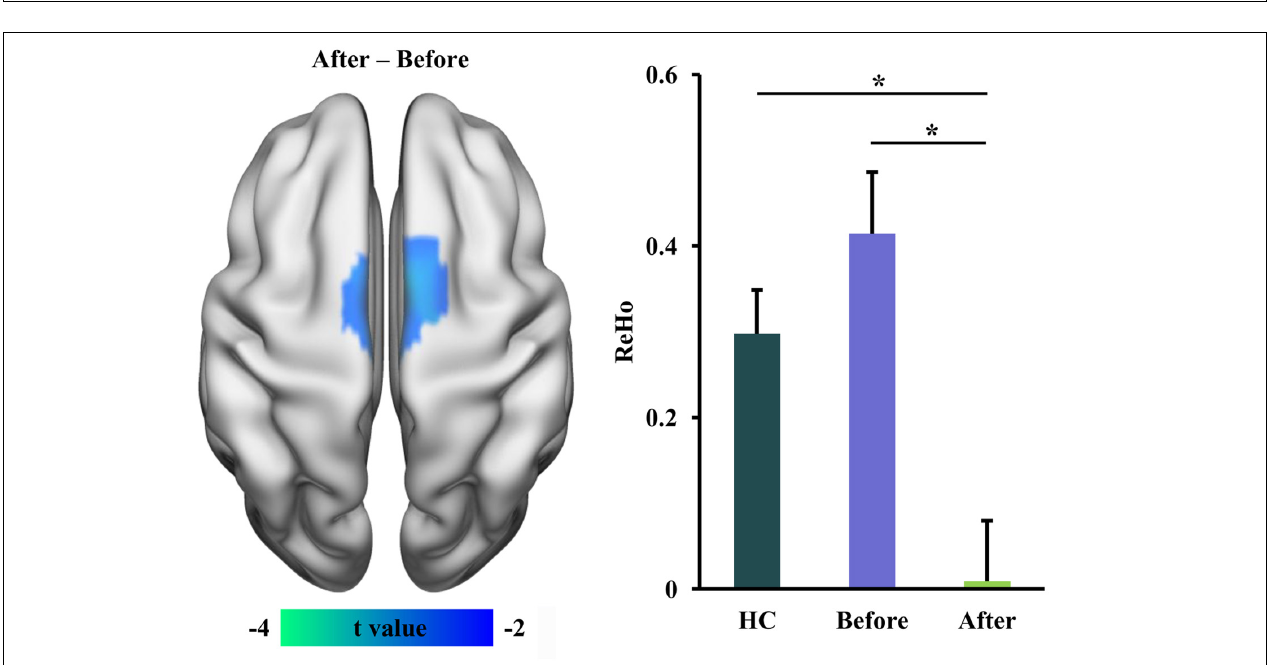
FIGURE 2 | Decreased regional homogeneity (ReHo) in restless leg symptom (RLS) patients after transcutaneous spinal cord direct current stimulation (tsDCS) treatment. Paired t -test found significantly decreased ReHo in supplementary motor area (SMA) in RLS patients after tsDCS compared to that before tsDCS. Regional mean ReHo values in SMA were calculated in healthy controls (HC) and RLS patients before and after tsDCS. Two-sample t -tests also found significantly decreased ReHo in RLS patients after tsDCS treatment compared to HC. No significant difference in ReHo between HC and RLS patients before tsDCS was found. * p <